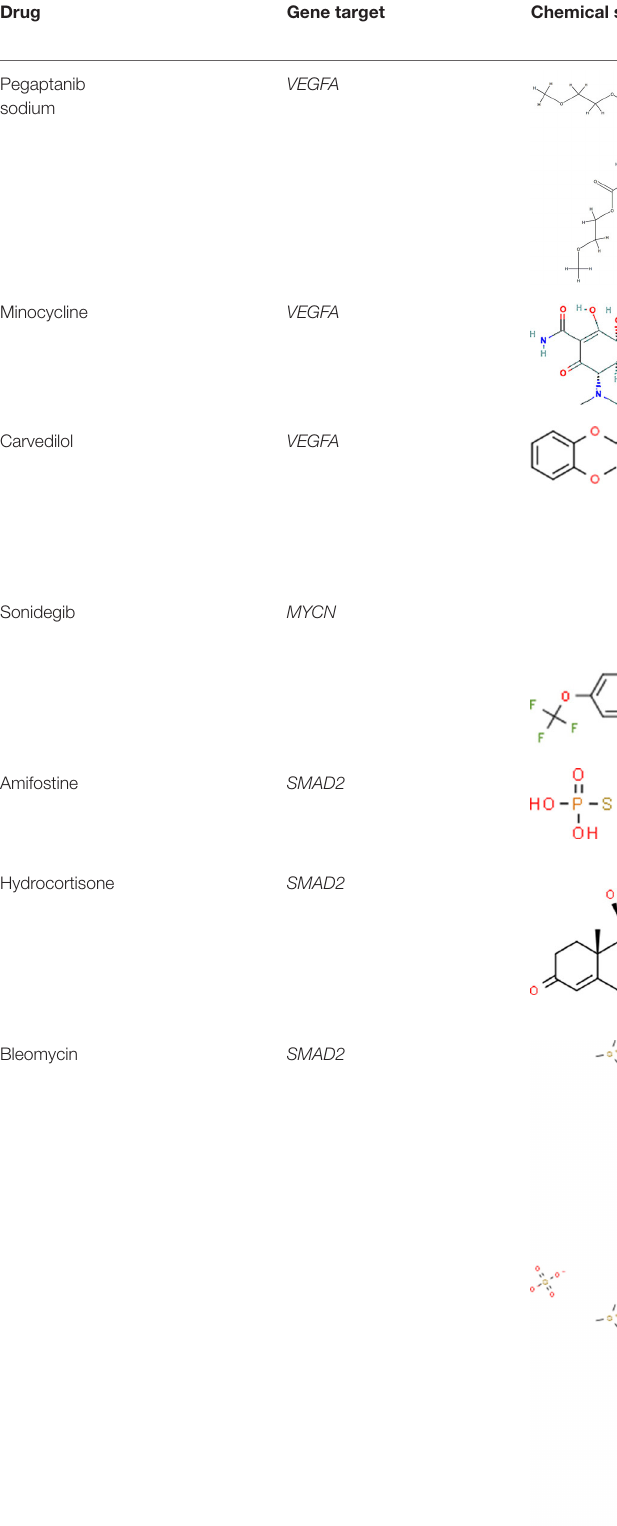
TABLE 5 | Chemical structure of the potential drugs that target the seven candidate genes.